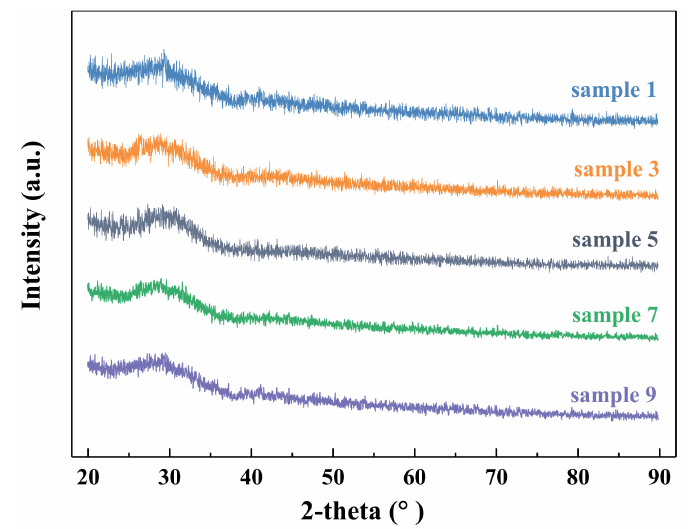
Figure 1. The XRD pattern of CaO–SiO 2 –Al 2 O 3 –CaO–MgO–TiO 2